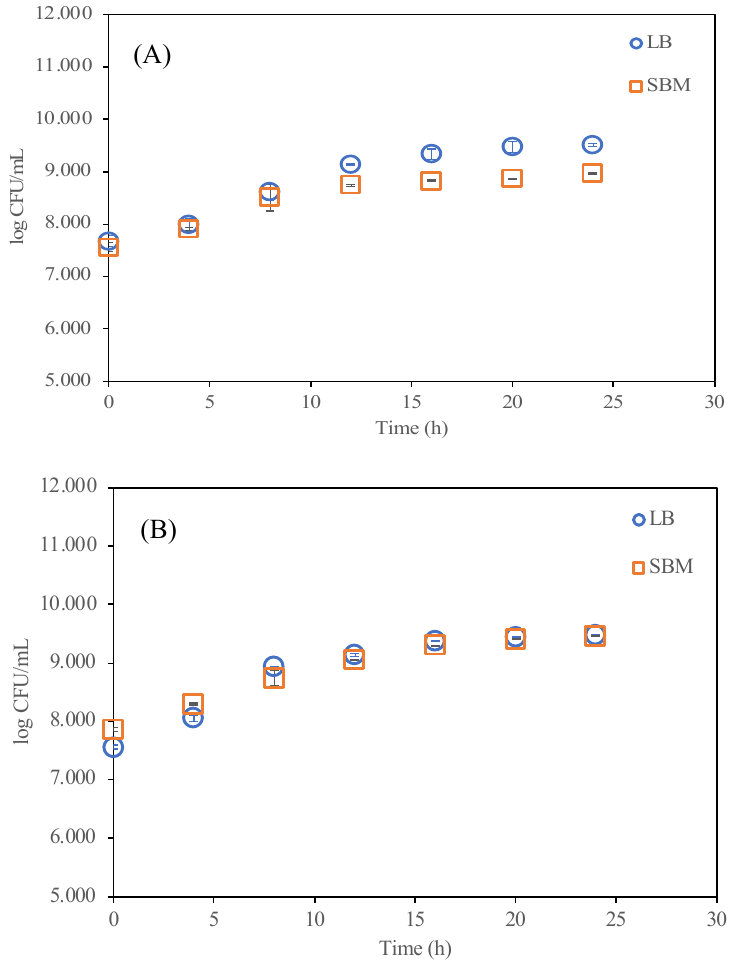
Figure 1. The cell growth of EHA105-pEAQ ( A ) and GV3101-pEAQ ( B ) cultivated in LB (LB medium) and SBM (sucrose-based defined medium). Error bars represent one standard deviation of six